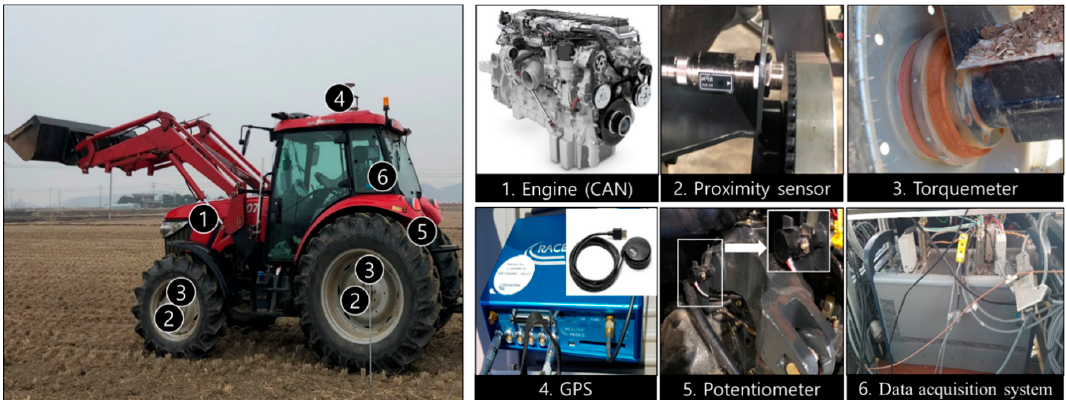
Figure 2. System installed on the tractor to collect field data for each major part: 1. Engine torque and engine speed, 2. Axle rotational speed, 3. Axle torque, 4. Travel speed, 5. Tillage depth, and 6. Data